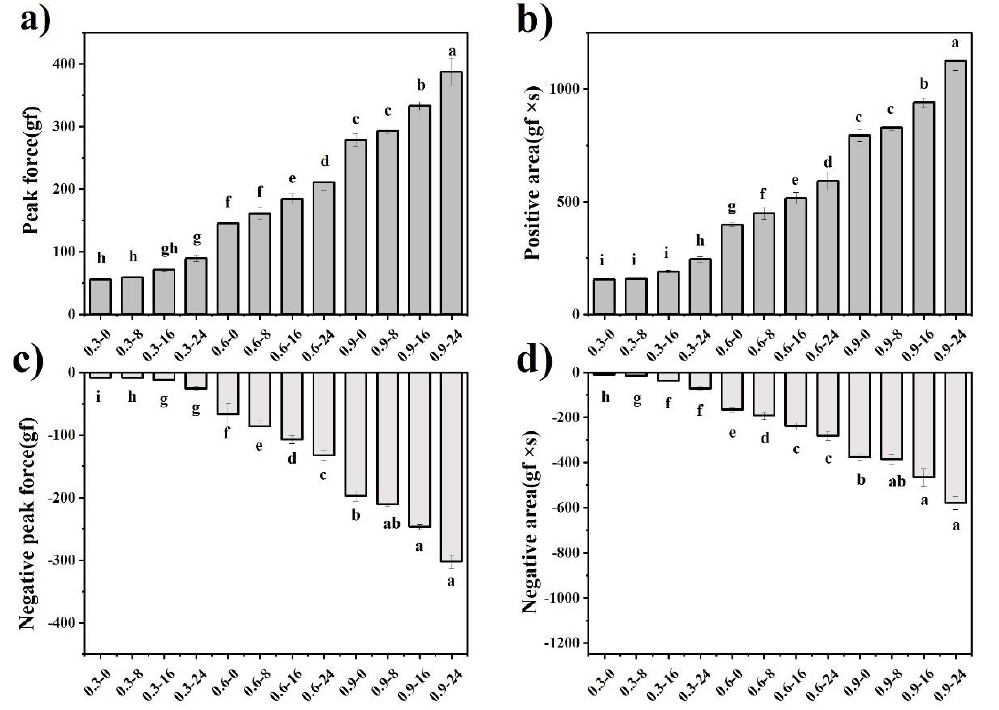
Figure 5. Instrumental texture parameters of model mayonnaises: ( a ) peak force-hardness; ( b ) positive area-consistency; ( c ) negative peak force-adhesiveness; ( d ) negative area-cohesiveness. Different letters above the bars indicate significant difference at p < 0.05.